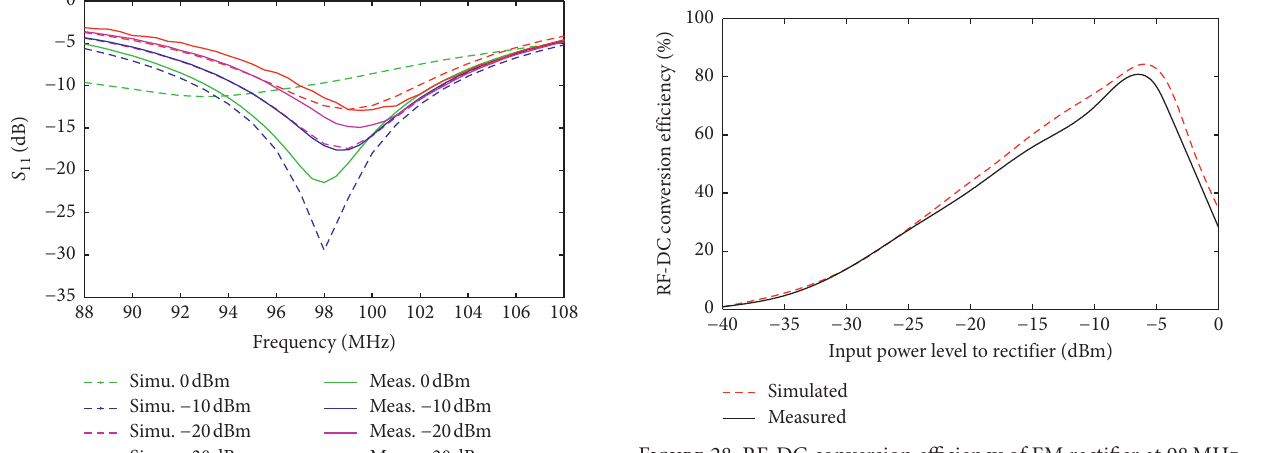
of FM rectifier for 10k Ω 11